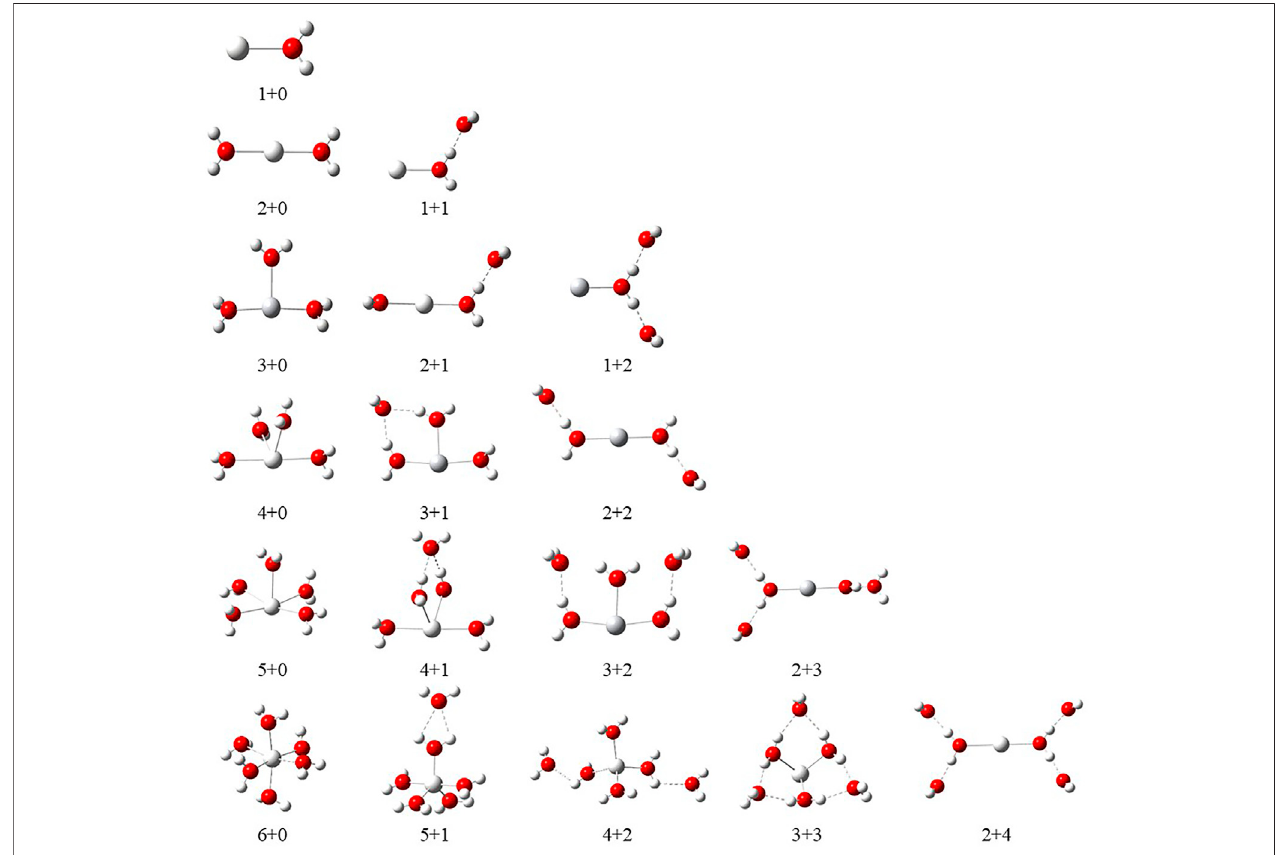
FIGURE 1 | Schematic representation of Sc z+ (OH 2 ) n , where z (cid:2) 1 – 3 and n (cid:2) 1 – 6, complexes and their nomenclature by a label of X + Y (X (cid:2) number of water molecules in the fi rst solvation shell and Y (cid:2) number of water molecules in the second solvation shell).